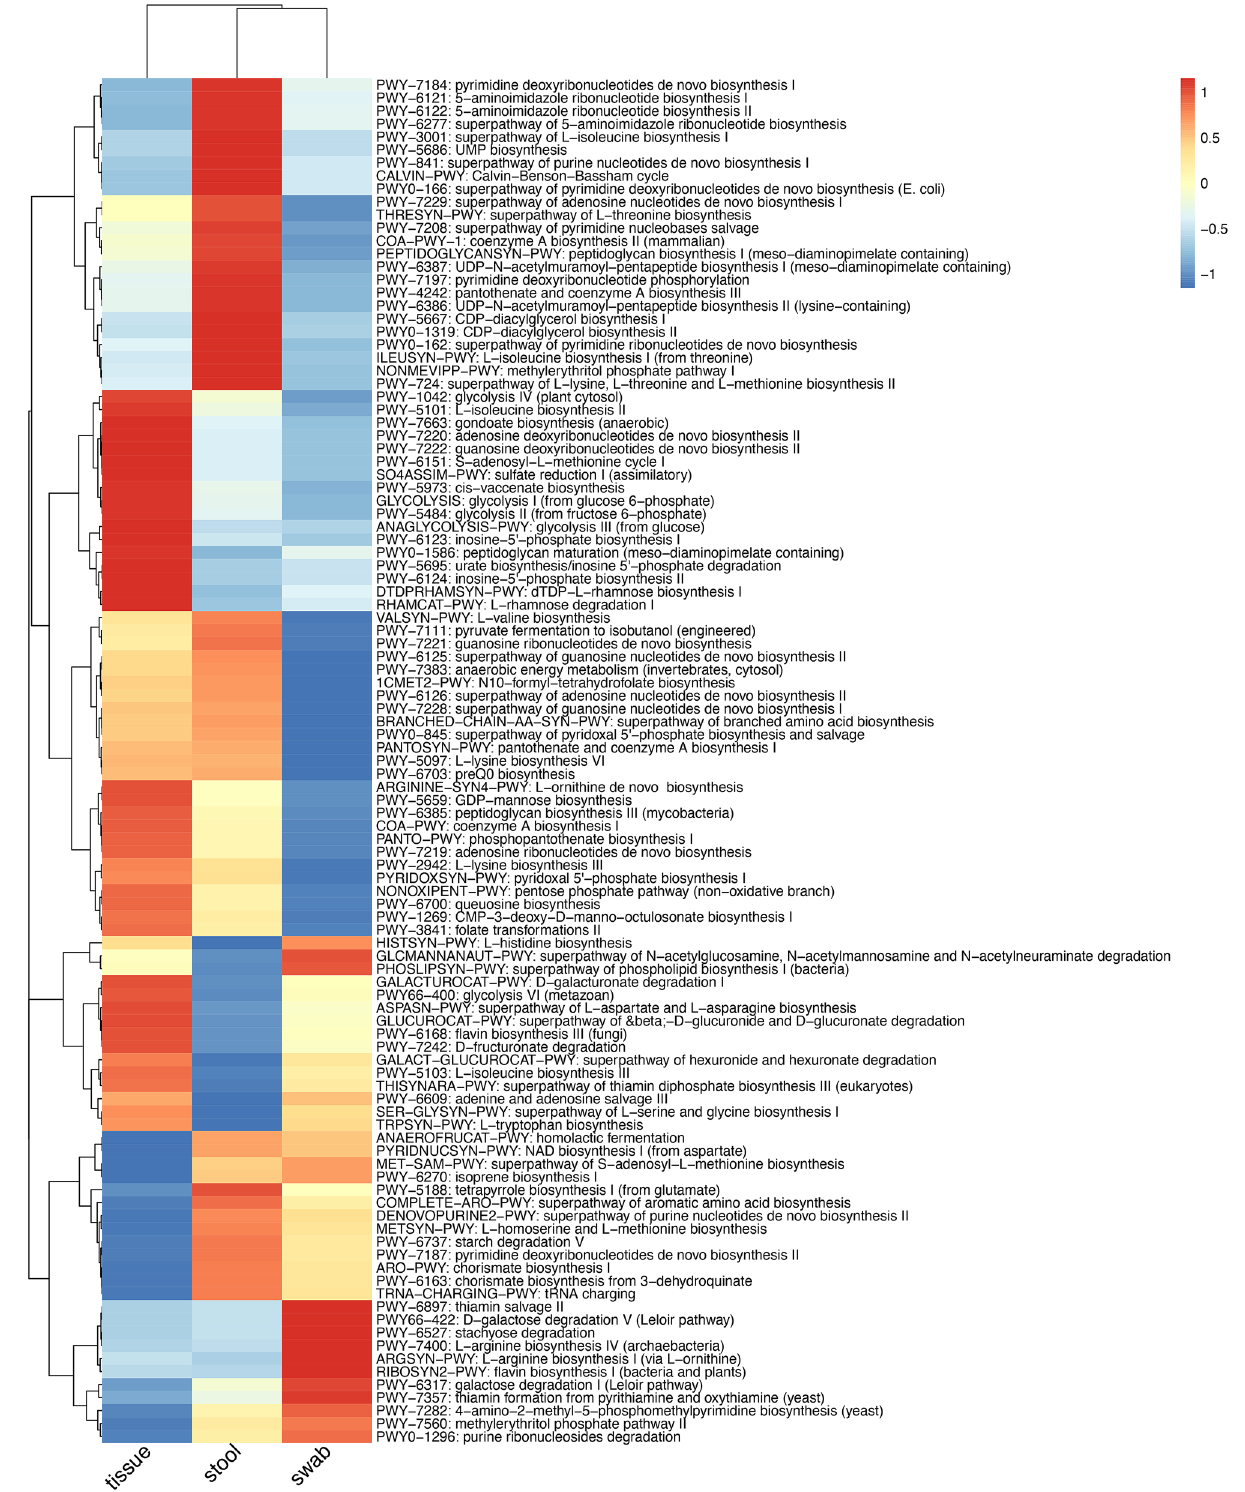
Figure 4. Heatmap of functional pathways that were significantly different between sample types (FDR < 0.05). Keys indicate z-scores of averaged